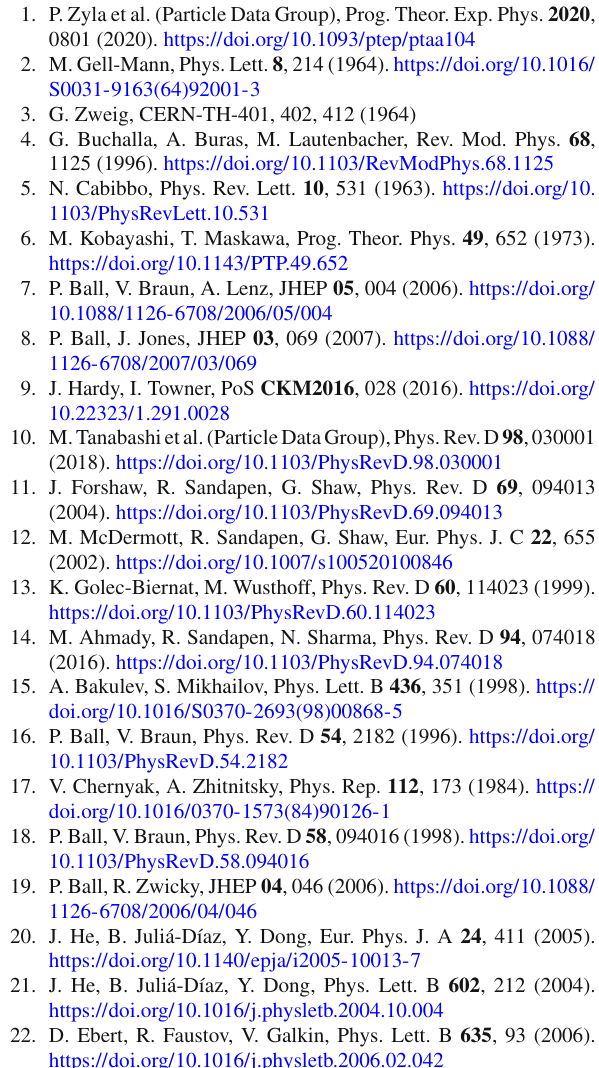
decays ρ ± , K ∗± → e − ¯ ν e , μ − ¯ ν μ might be measurable due right holder. To view a copy of this licence, visit http://creativecomm ons.org/licenses/by/4.0/. to the huge data of the ρ ± and K ∗± mesons at LHCb. (2) Funded by SCOAP 3 decays are favored by the CKM element The PLDCV D ∗ s | . Their branching ratios are about O ( 10 − 6 ) . The PLDCV | V cs → e − ¯ ν μ − ¯ ν μ , τ − ¯ ν τ could be carefully studied decays D ∗ e , d , s at the Belle-II, SCTF or STCF, CEPC, FCC-ee, LHCb exper- mesons below the B π thresholds and iments. (3) For the B ∗ u mesons below both BD and B c π thresholds, they the B ∗ c decay predominantly through the magnetic dipole transi- decays favored tions. The branching ratios of the PLDCV B ∗ c by the CKM element | V cb | could reach up to O ( 10 − 6 ) . The